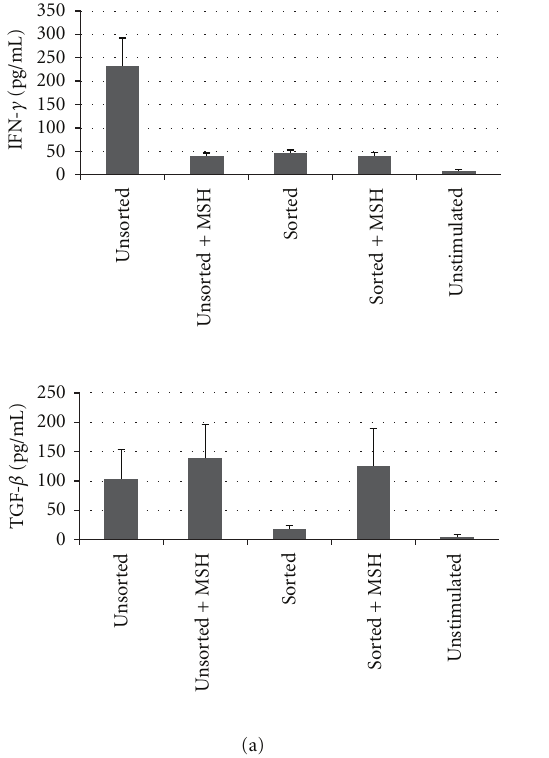
Figure 4: The e ff ects of α -MSH on CD25 − CD4 + T cells. The CD4 T cells were isolated from the draining lymph node as in Figure 1 and were stained with CD25 antibody. The stained cells were sorted, and the CD25 − cells were placed in culture, stimulated, and treated with α -MSH. (a) After 48 hours, the supernatant was assayed for IFN- γ and TGF- β . The sorted CD25 − CD4 + T cells (Sorted) did not produce IFN- γ or TGF- β ; however, when treated with α -MSH (Sorted + MSH) did produce TGF- β but not IFN- γ . (b) The α -MSH-treated CD25 − CD4 + T cells were transferred to cultures of activated Th1 cells. After 48 hours of incubation IFN- γ was measured in the supernatant. There was no statistical di ff erence in IFN- γ production by the Th1 cells in culture with or without α -MSH-treated CD25 − CD4 + T